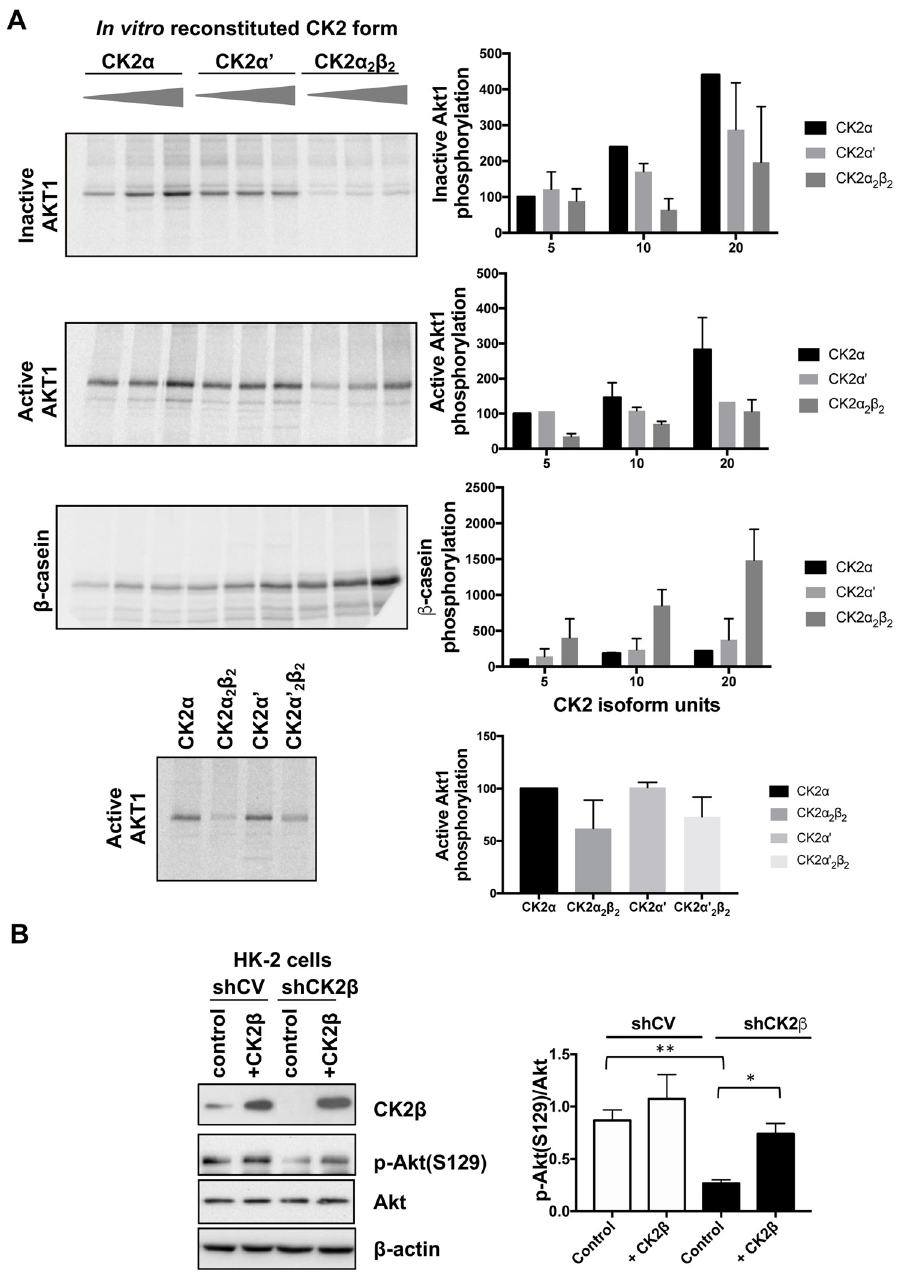
Fig 2. Phosphorylation of Akt by different forms of CK2. (A) Increasing amounts of CK2 α (1.25, 2.5 and 5 ng), CK2 α ’ (40, 80 and 160 ng) or CK2 α 2 β 2 (2.5, 5 and 10 ng), corresponding to equal activity towards CK2-tide peptide, were incubated with 0.3 μ g of active Akt1 or 0.3 μ g of inactive Akt1, or 1 μ g β -casein as a control. In the right panel, 0.3 μ g of active form of Akt was incubated with CK2 α (1.25 ng), CK2 α 2 β 2(5 ng), CK2 α ’ (40 ng) or CK2 α ’2 β 2 (25 ng) in the presence of 150 mM NaCl. The amount of each enzyme used was equally active against the CK2 specific peptide (CK2-tide: RRRADDSDDDDD ) as determined by kinase activity assays (not shown). Upon radioactive phosphorylation, proteins were separated by SDS-PAGE. A representative digital autoradiography of the dried gel is shown. The bar graph on the right shows the relative quantitation of the bands (means ± SEM, n = 3), performed by analysis with CyclonePlus Storage Phosphor System, (PerkinElmer); the unit amounts of each isoform are indicated, and activity is reported as % of that measured with 5 units of CK2 α . (B) shCV HK-2 and shCK2 β HK-2 were transiently transfected with CK2 β pCMV-HA vector. Representative Western blot analysis with the indicated antibodies is shown. β -actin was used as a loading control. Quantification (p-Akt(S129)/ AKT) is shown on the bar graph on the right (means ± SEM, n =